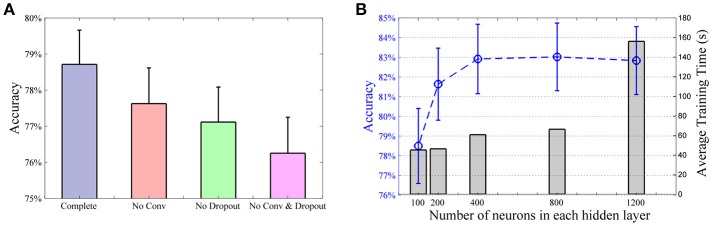
Analysis of CNN structure. (A) Effects of convolutional layer and dropout method. Compared to the model with no convolutional layer nor dropout layer (i.e., a standard ANN), incorporating the convolutional layer or the dropout resulted in a rise in classification accuracy of 1.4% and 0.9%, respectively. Furthermore, the complete CNN classifier offered a 2.5% improvement than the standard ANN. All pairwise comparisons are statistically significant. (B) Average accuracy (blue line) and training time (gray bars) of the first 10 subjects with different number of neurons in CNN hidden layers. Same number of neurons are used in each hidden layer.